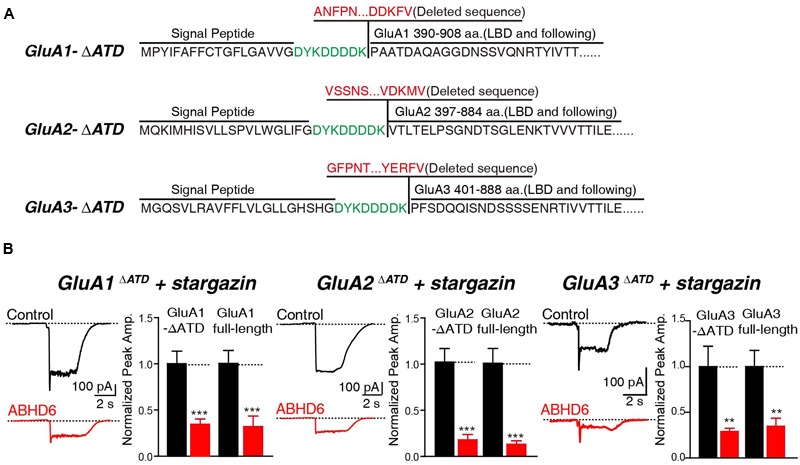
The N-terminus of GluAs were not required for ABHD6-induced inhibition. (A) The amino acid sequences of GluA1–3 N-terminal deletion constructs. (B) Representative traces (left) and summary graphs of the peak amplitudes (right) of 10 mM glutamate-induced currents in HEK293T cells transfected with GluA1–3 N-terminal deletions, stargazin, and a control vector or vectors encoding ABHD6 (GluA1ΔATD, control: 24/3, ABHD6: 24/3, p < 0.001; GluA1 full-length, control: 27/3; ABHD6: 27/3; peak: p < 0.001; GluA2ΔATD, control: 26/3, ABHD6: 26/3, p < 0.0001; GluA2 full-length, control: 30/3; ABHD6: 30/3; peak: p < 0.0001; GluA3ΔATD, control: 24/3, ABHD6: 24/3, p < 0.01; GluA3 full-length, control: 27/3; ABHD6: 27/3; peak: p < 0.01). Each graph of the peak amplitude in HEK293T cells transfected with various ABHD6-expressing vectors was normalized to the peak amplitude in HEK293T cells transfected with the control vector. All summary graphs show means ± SEMs; statistical comparisons by Student’s t-test yielded: ∗p < 0.05, ∗∗p < 0.01, ∗∗∗p < 0.001.